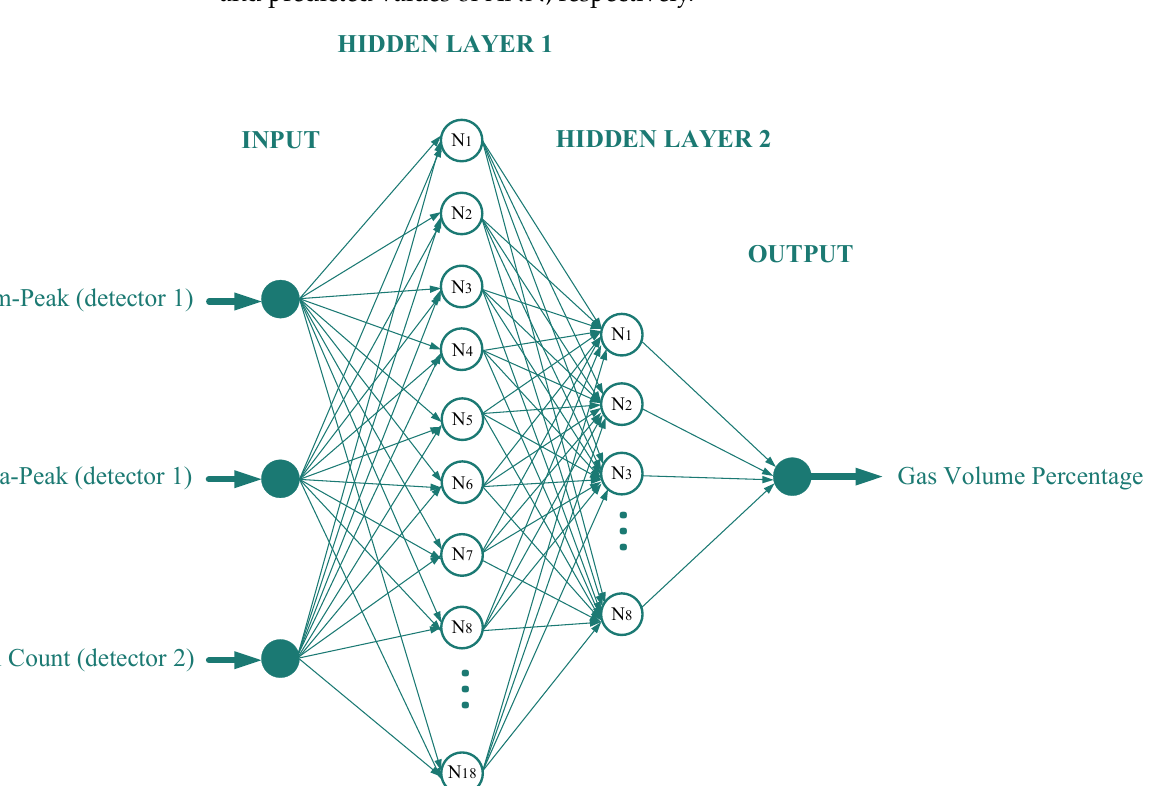
Oil Volume Percentage Figure 4. MLP Neural network for predicting oil volume percentage. Table 1. The specifications of predictor MLP neural networks. ANN Gas Volume Percentage Predictor